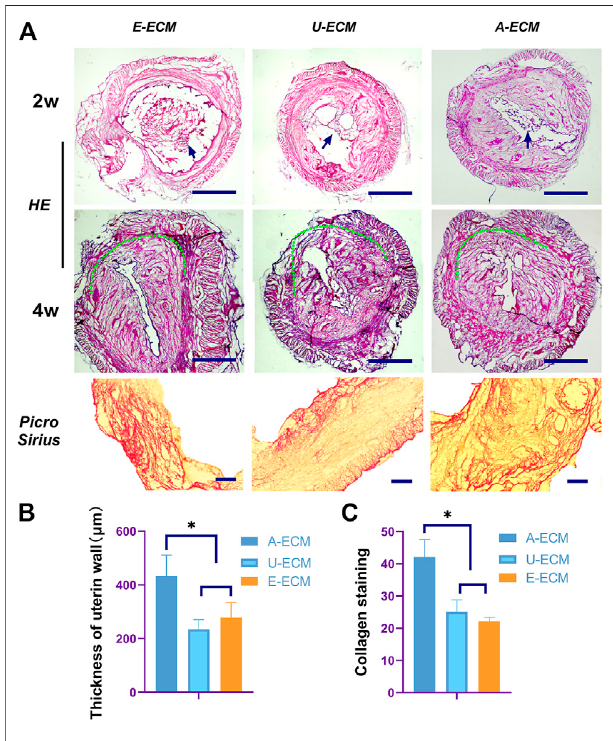
FIGURE 4 | Morphological assessment of the regenerated endometrium. Two and 4 weeks after surgery (A,B) , HE and Picro Sirius staining were used to evaluate the thickness of the regenerated endometrium and the collagen contents (C) in all the groups.* p < 0.05, one-way ANOVA with Tukey ’ s post hoc test. Bar = 500 μ m in the HE images and bar = 500 μ m in the Picro Sirius staining images. Arrows shown the damaged area of the uterine horn in each